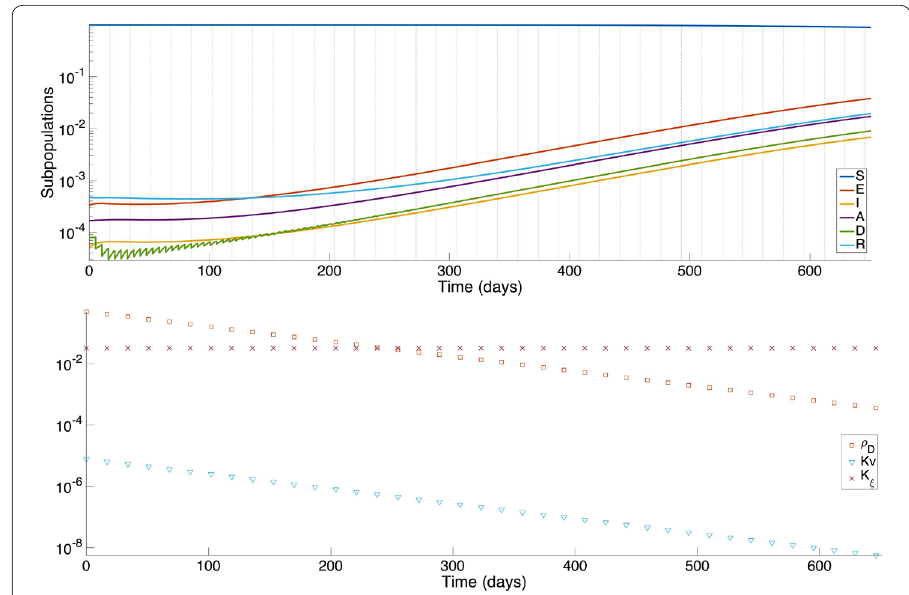
Figure 5 ( a ) Dynamics of the subpopulations through time; ( b ) values of the parameters of the control strategy through